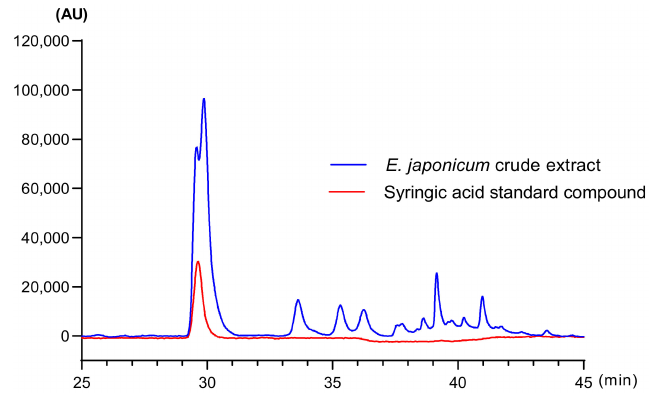
Figure 1. High-performance liquid chromatography (HPLC) chromatogram for standardization of the E. japonicum extract (EJE). The concentration of syringic acid as a standard compound was 7.6 ± 0.62 mg / g. AU, area